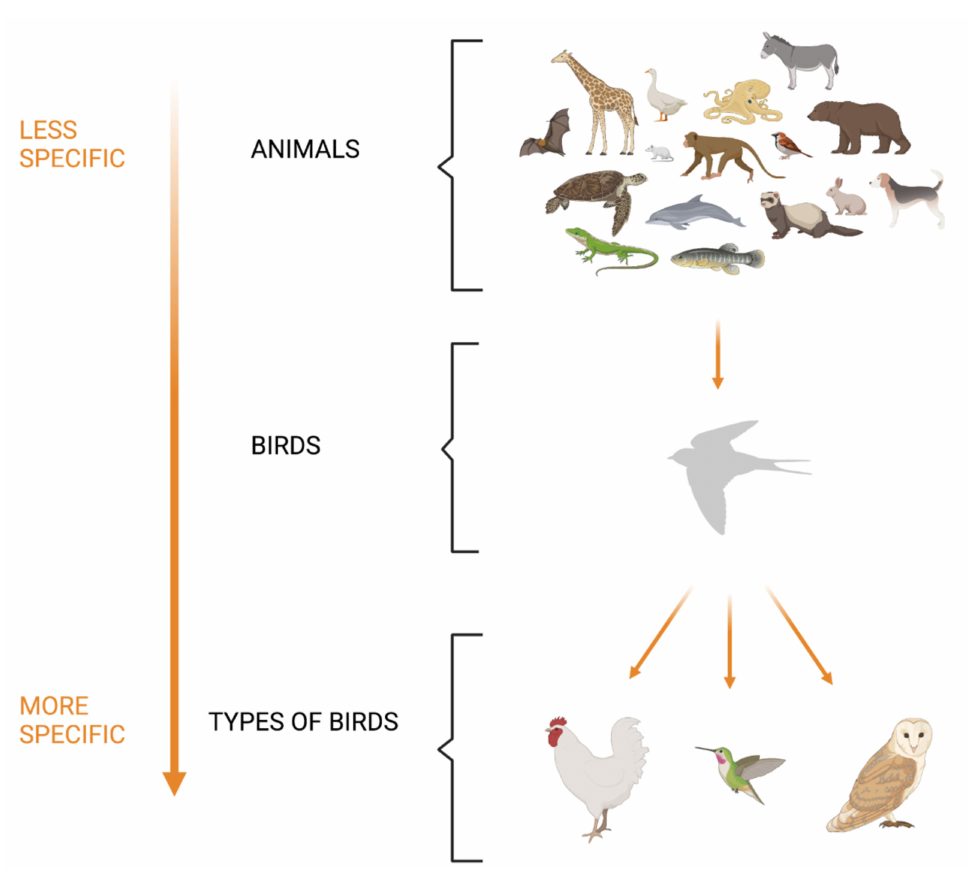
Figure 1. Organisation of the semantic memory category system and its implications for semantic breakdown in svPPA. The characteristic pattern of semantic organisation for the concept “birds” is illustrated in the picture above. Superordinate categories (e.g., animals) sit at the top of the semantic hierarchy. They display a high degree of generality and low specificity among the features shared by their members. Subordinate categories are a more specific level of categorisation, e.g.,” birds” is a subordinate category of “animals” and “hummingbird” is a subordinate category of “birds”. At the bottom of the hierarchy sit the most specific attributes, which are also those to degrade first in svPPA, e.g., “a hummingbird is a very small bird, feeds on flower nectar and can hover”. A typical patient with svPPA may initially name the picture of a hummingbird correctly, but as the disease progresses, errors and superordinate responses would emerge in the following pattern: Assessment 1: Hummingbird → “hummingbird” (named correctly); Assessment 2: Hummingbird → “sparrow” (named as a semantically similar category coordinate); Assessment 3: Hummingbird → “bird” (named as a higher-familiarity typical member of the category); Assessment 4: Hummingbird → “animal” (named as the superordinate category); Assessment 5: Hummingbird → “I don’t